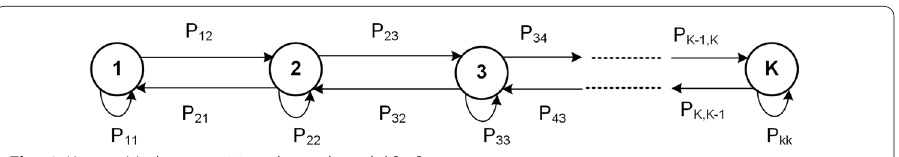
Fig. 6 K‑state Markov transition channel model